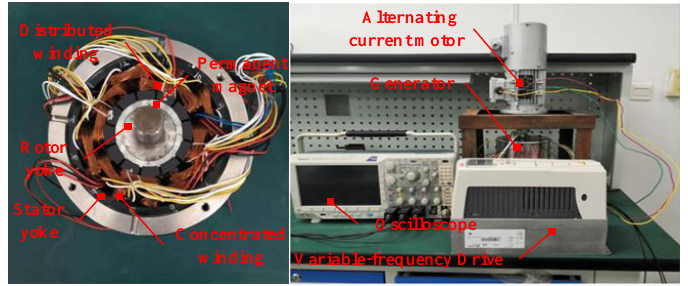
Figure 27. Experimental setup for the generator.